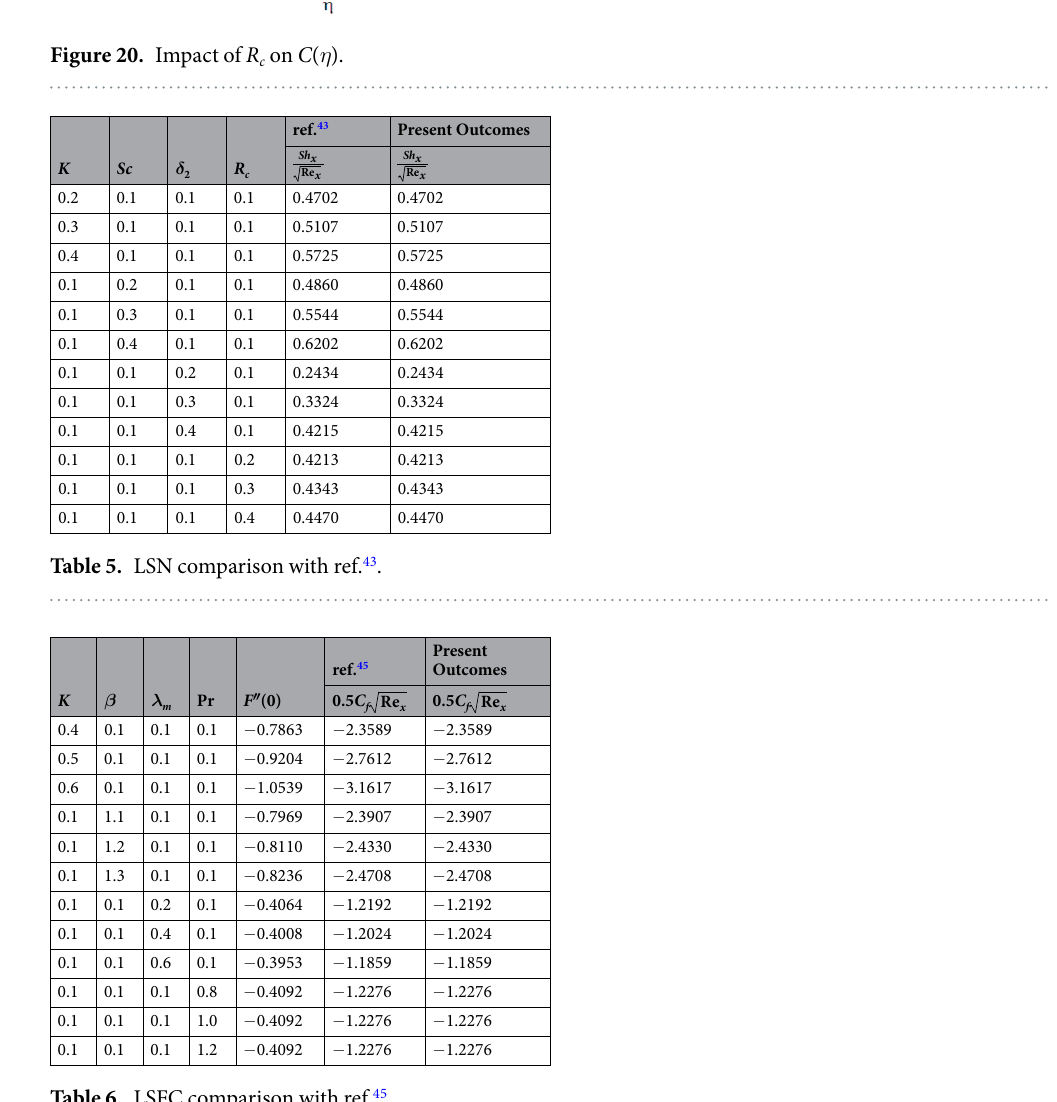
Table 6. LSFC comparison with ref. 45